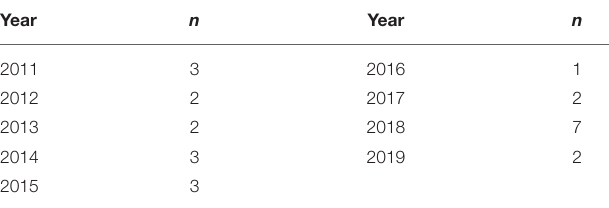
TABLE 1 | Number of reviewed studies in terms of publication